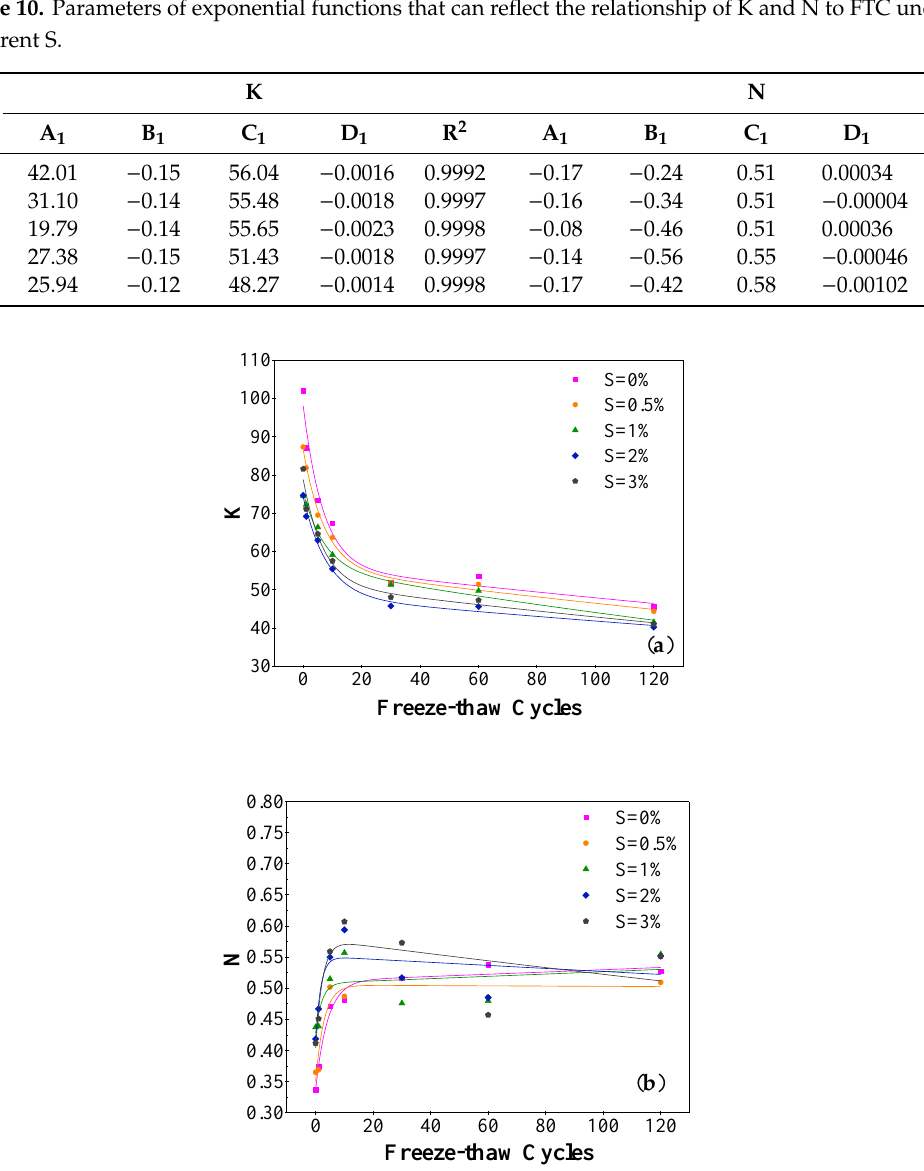
Figure 8. Variation of K and N with FTCs of different confining pressures: ( a ) K and ( b ) N. Table 10. Parameters of exponential functions that can reflect the relationship of K and N to FTC under different S.